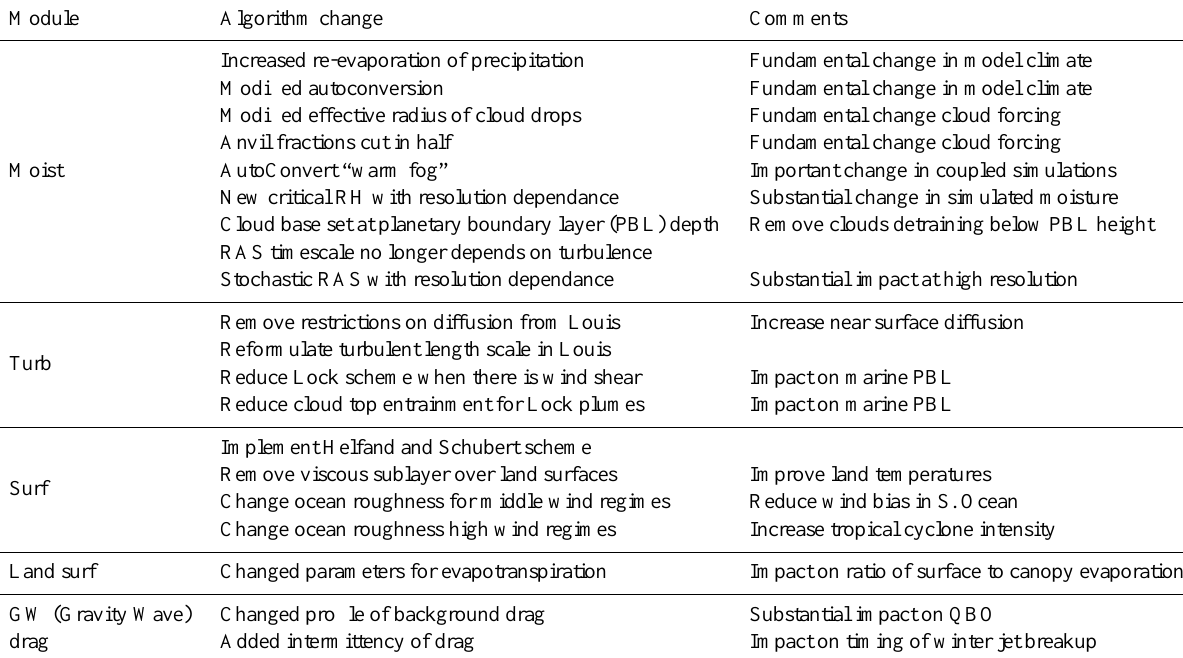
Table 1. Changes in GCM Algorithms from MERRA to